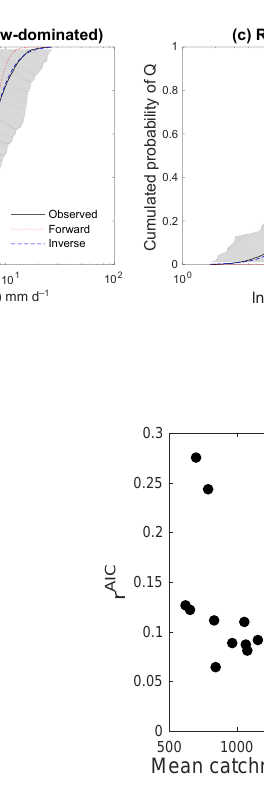
Figure 10. Relative increase in the performance of the nonlinear model with respect to the linear model (as measured by r AIC ) as a function of mean catchment elevation. All model parameters are estimated in inverse